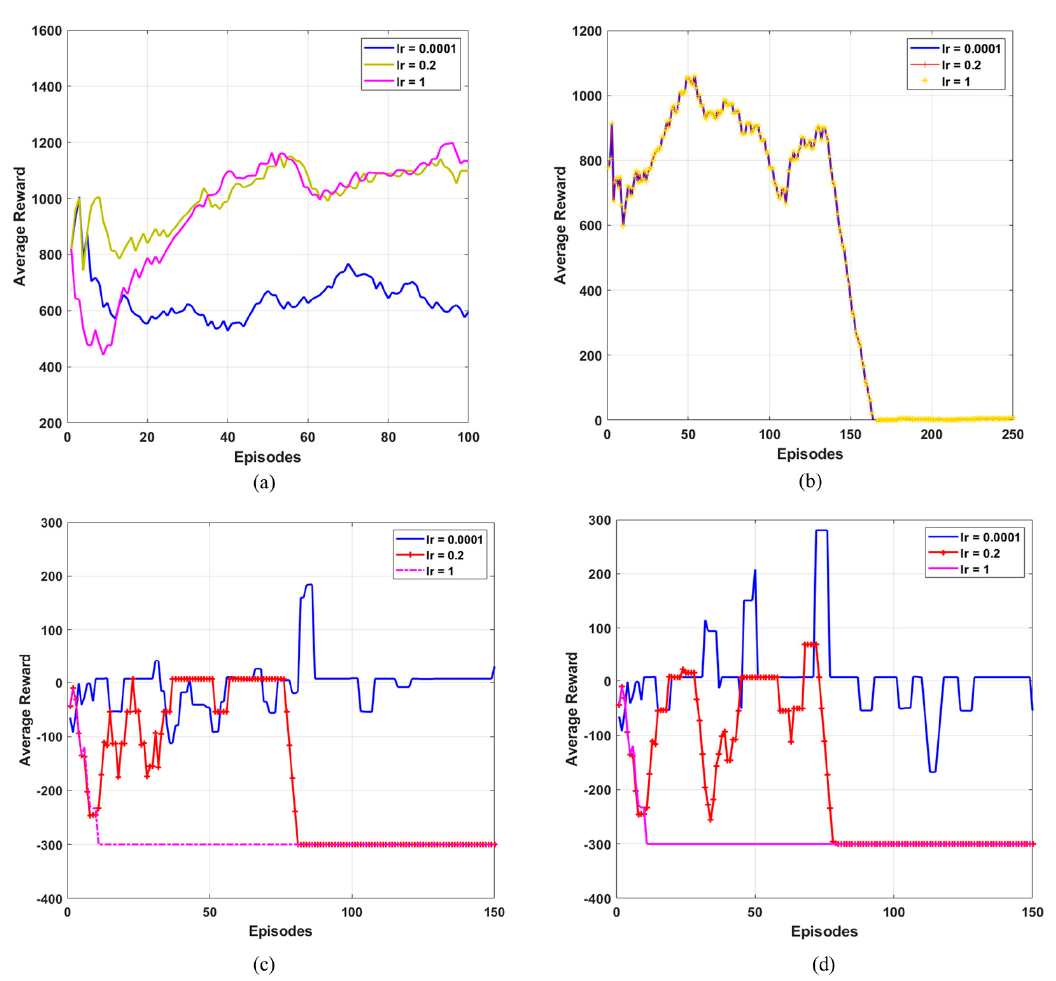
Figure 11. Convergence Speed with Different Learning Rate ( a ) Q-Learning ( b ) SARSA ( c ) DQN, and ( d ) Double DQN.